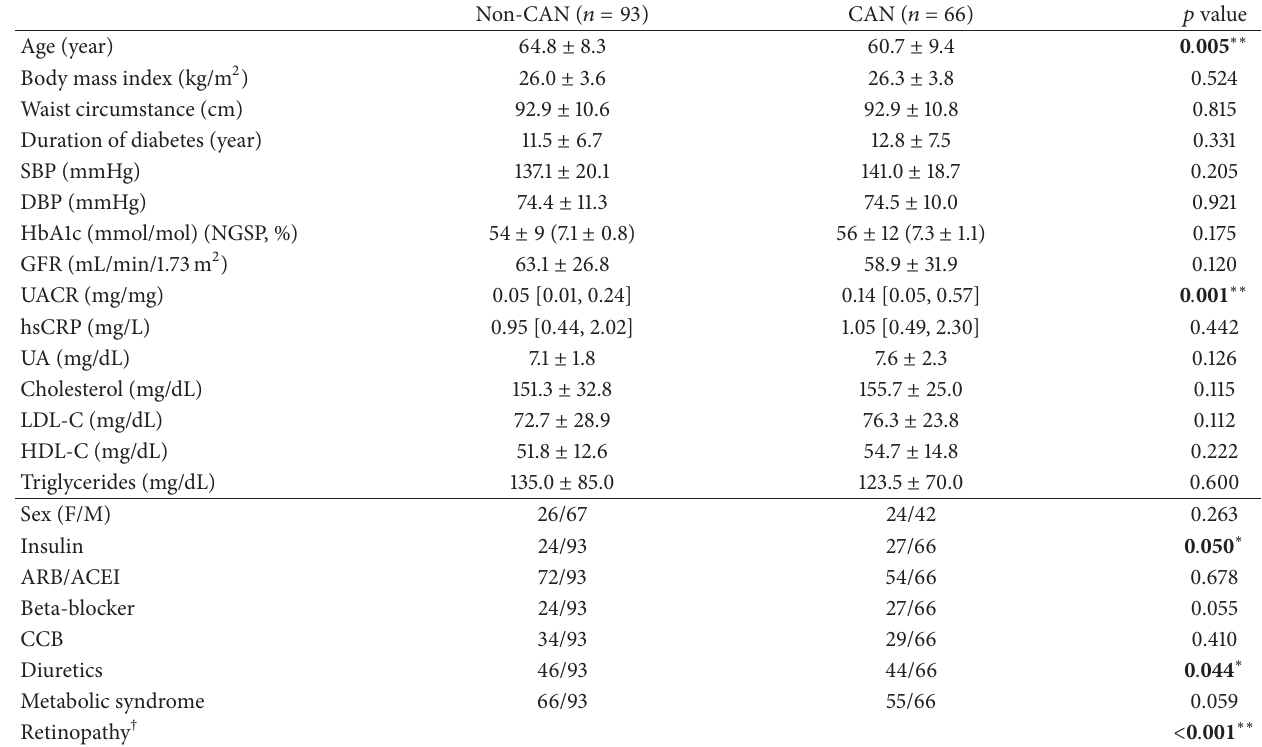
Table 3: Demographic data between groups of CAN and non-CAN.